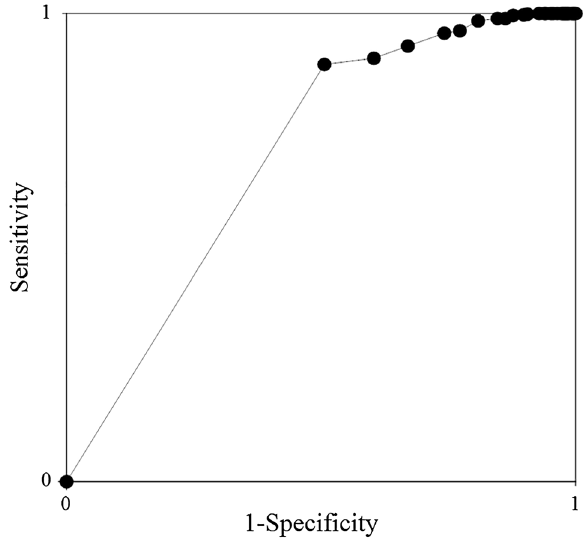
Figure 2. Receiver operating characteristic curve showing the diagnostic value of the volume of red blood cell transfused in predicting PIICS in ICU patients. The area under the curve is 0.70. ROC receiver operating characteristic, PIICS persistent inflammation, immunosuppression, and catabolism syndrome.